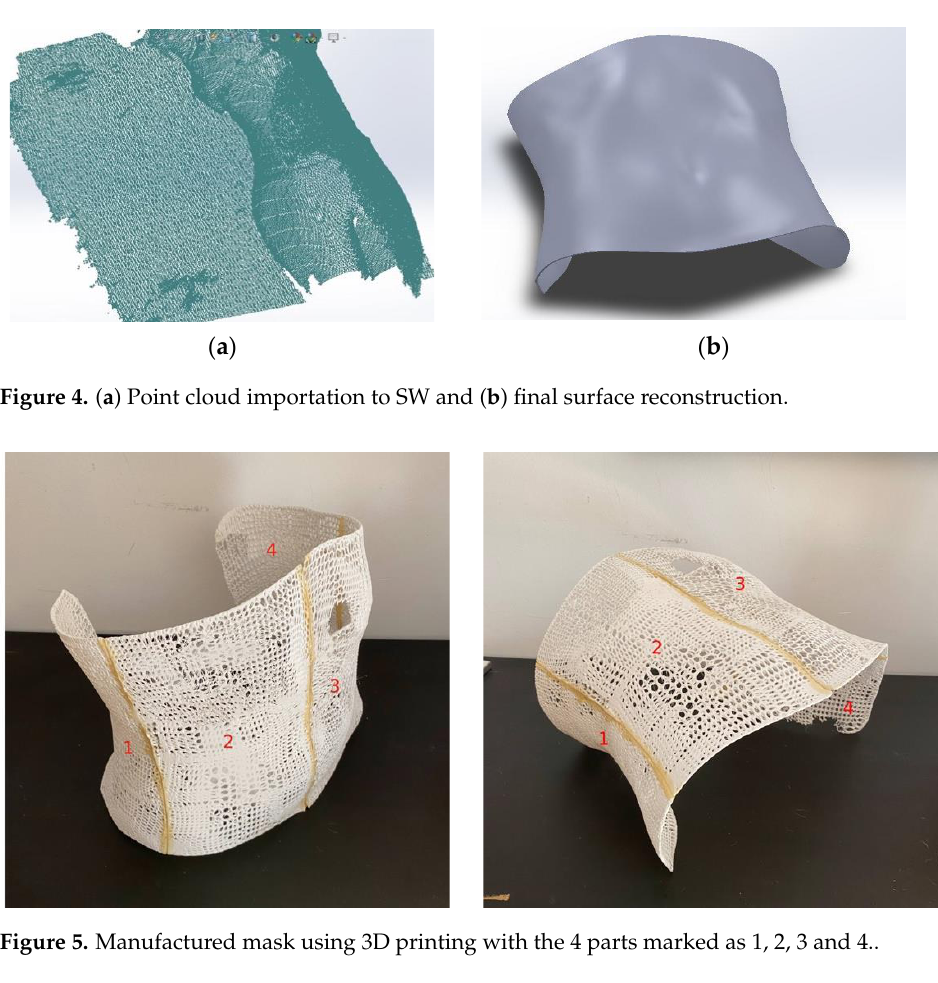
Figure 4. ( a ) Point cloud importation to SW and ( b ) final surface reconstruction.